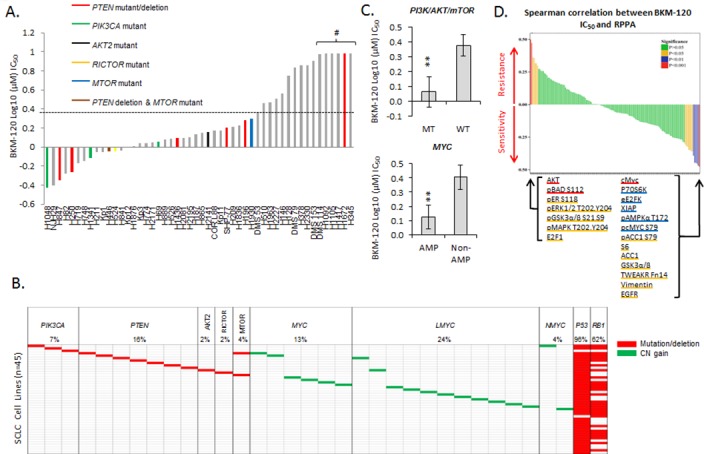
BKM-120 inhibits SCLC growth in vitro.(A) Proliferation assays showed a range of sensitivities to BKM-120 across the SCLC cell line panel. Cell lines with PTEN mutations/deletions are colored red and those with PIK3CA mutations green; clinical Cmax is indicated with a dashed horizontal line. # indicates IC50 not reached at doses tested. (B) Summary of PI3K/mTOR mutation and MYC amplification status of the cell lines (see S3 Fig for cell line names). (C) Cell lines with either a mutation in the PI3K/mTOR pathway (MT) or a MYC amplification (AMP) were more sensitive to BKM-120 than cells without a mutation or amplification (WT and NON-AMP; ** p<0.02.). (D) Biomarker discovery using the RPPA profiles of 47 SCLC cell lines correlated protein expression with BKM-120 IC50 to identify markers predictive of response. Proliferation data are presented as mean ± SEM.